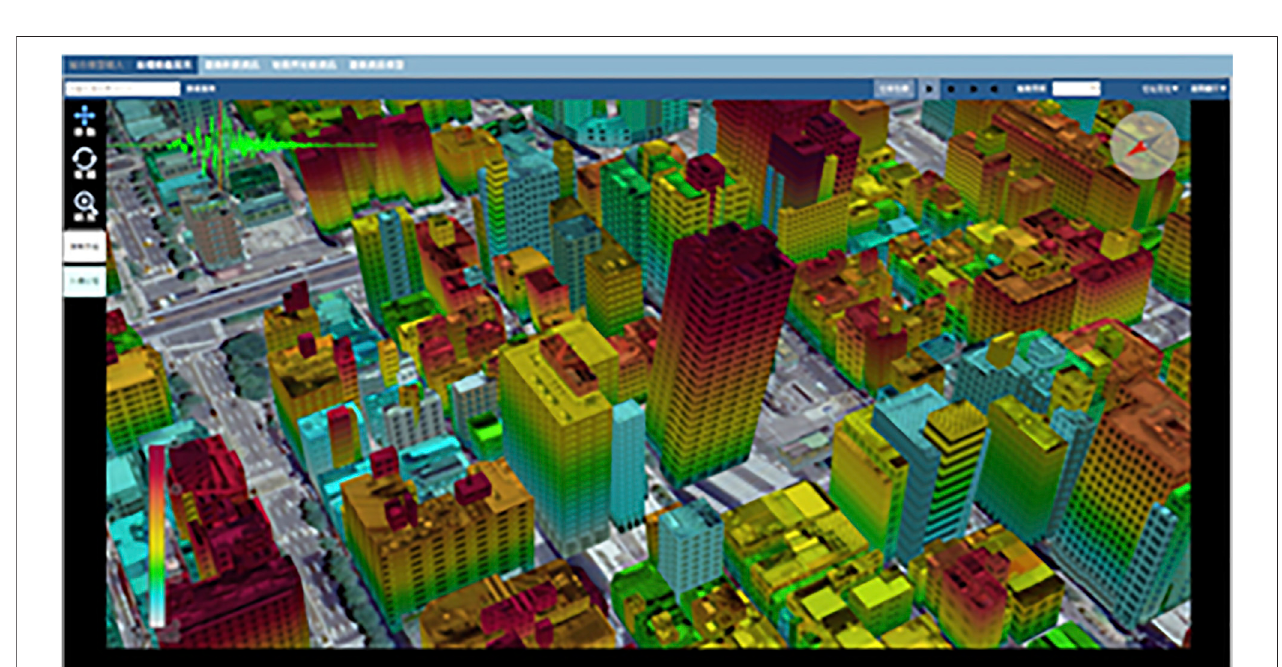
FIGURE 11 | Simulation of the impact of earthquakes on urban buildings with the MDUES platform.